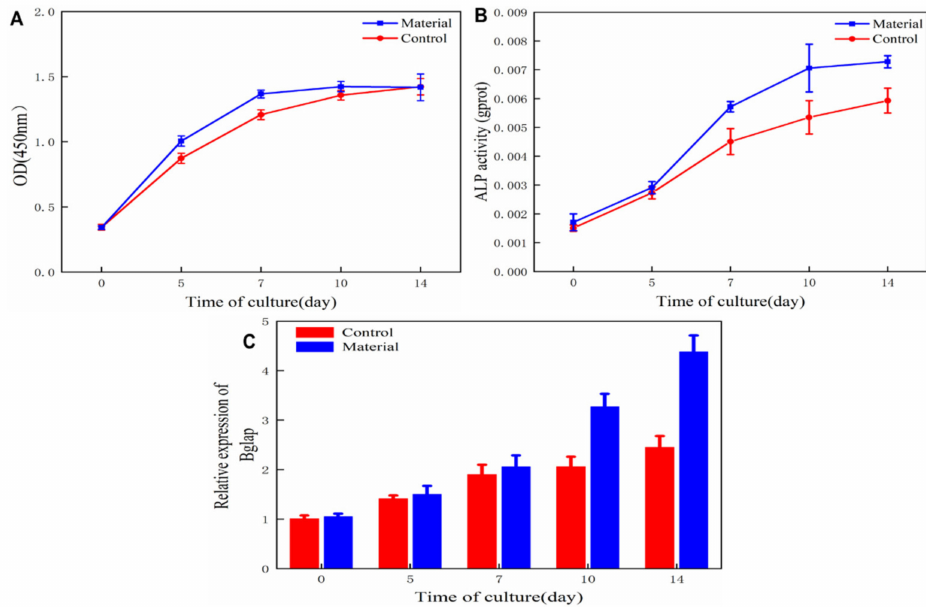
Figure 6. Cell proliferation rate ( A ), cell ALP activity ( B ), and relative mRNA expression level of cell osteocalcin ( C ) of the scaffold treated group and control